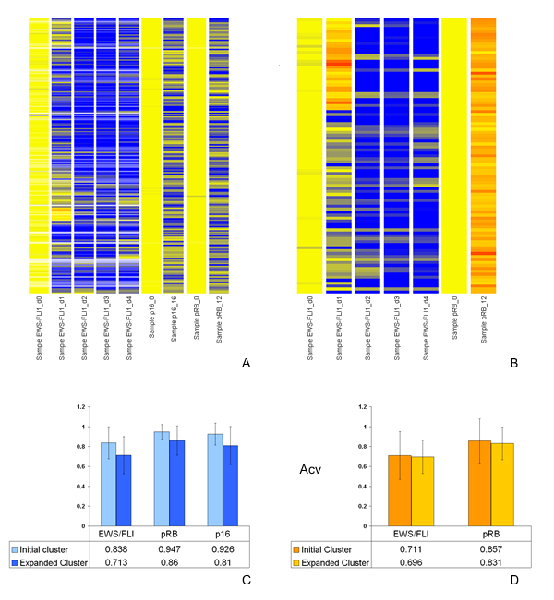
Expanded signatures. (A) 210 probesets down regulated by EWS/FLI, p16, and pRB. Sample EWS-FLI1_d0, sample of EWS/FLI dataset analyzed at day 0; Sample p16_0, sample of p16 dataset analyzed at 0 hours; Sample pRB_0, sample of pRB dataset analyzed at 0 hours. Red means up regulation, relative to control conditions (Sample EWS-FLI1_d0 for EWS/FLI dataset; Sample p16_0 for p16 dataset; Sample pRB_0 for pRB dataset), blue means down regulation. (B) 93 probesets up regulated by pRB and down regulated by EWS/FLI. (C) Average of correlation values (Acv) for initial set of probesets identified mining published lists (initial cluster) and for the expanded cluster. Acv are calculated on probesets down regulated by EWS/FLI, pRB, and p16. Error bars represent the standard deviation of the correlation values. (D) Acv calculated for probesets up regulated by pRB and down regulated by EWS/FLI.